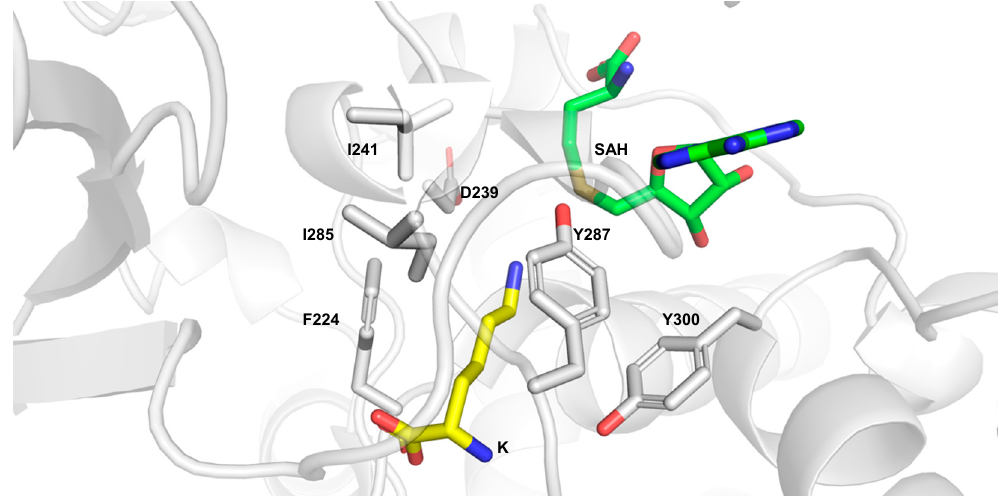
Figure 6. Ribbon representation of Rubisco large subunit methyltransferase (RLSMT) (grey) bound to K (yellow) and S-adenosylhomocysteine (SAH) (green). Asp239 and Ile241 stabilize binding to the substrate via a water-mediated hydrogen bond (not depicted). (PDB-ID: 1OZV (K)). Histone lysine methyltransferases are mostly specific towards one methylation state.